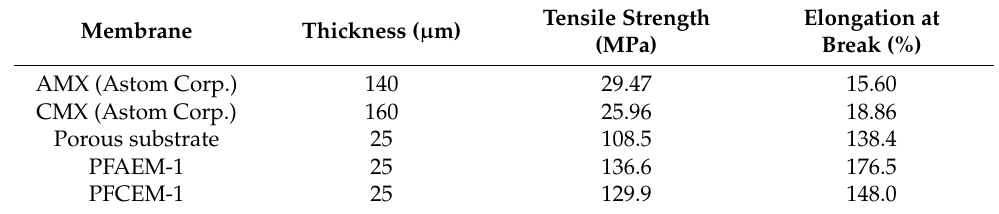
Table 4. Tensile strength and elongation at break of commercial IEMs, porous substrate, and PFIEMs.